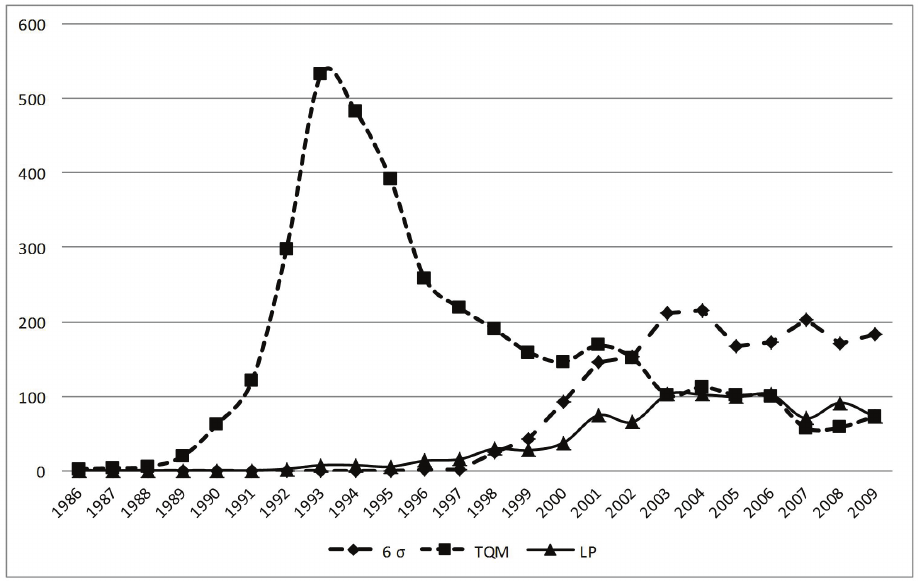
Fig. 1. Annual number of texts (adjusted) entitled 6σ, TQM and LP in the